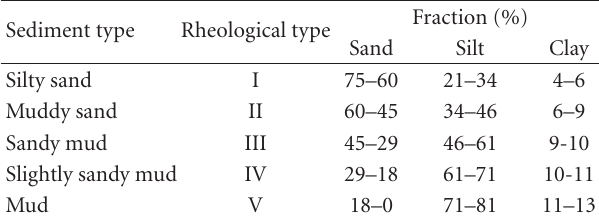
Figure 3: Relation between solid fraction sediments and yield stress for the 5 types. Table 2: Five types of sediments in